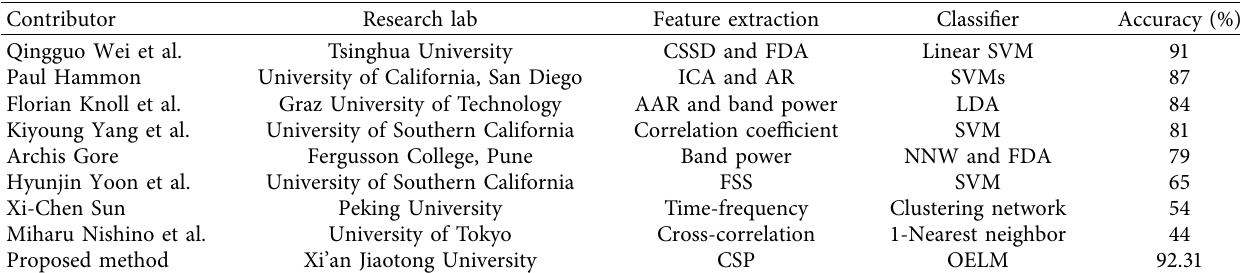
Figure 8: Evaluation index of ELM and OELM under the two activation functions. Table 6: Classification results comparing the proposed system with other systems.